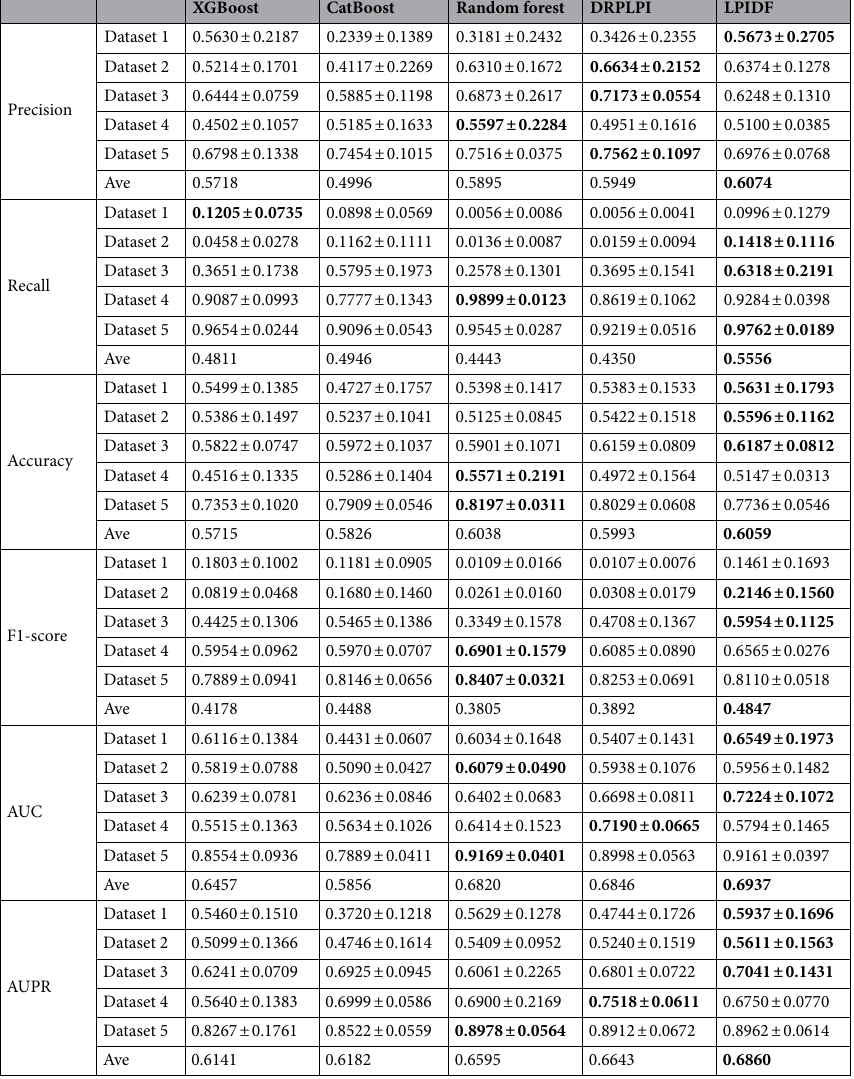
Table 2. The performance of five LPI prediction methods on CV2. The best performance is represented in boldface in each row in each